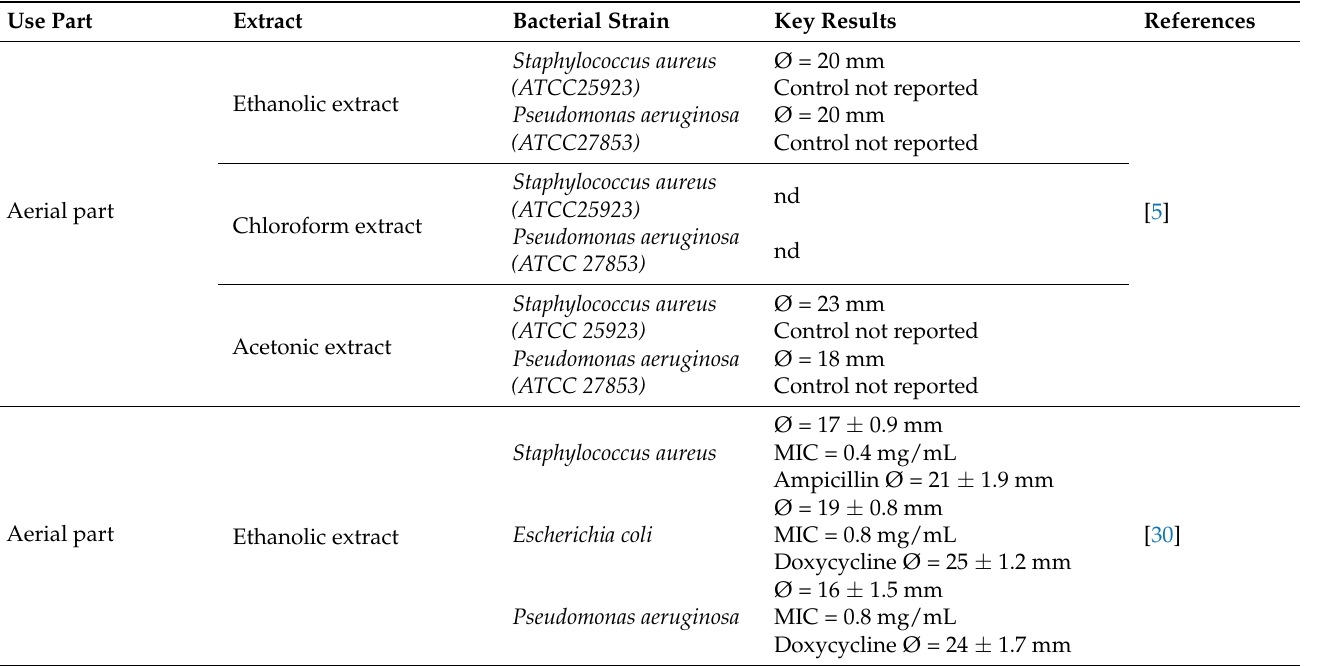
Table 3. Antibacterial activity of V. tortilis